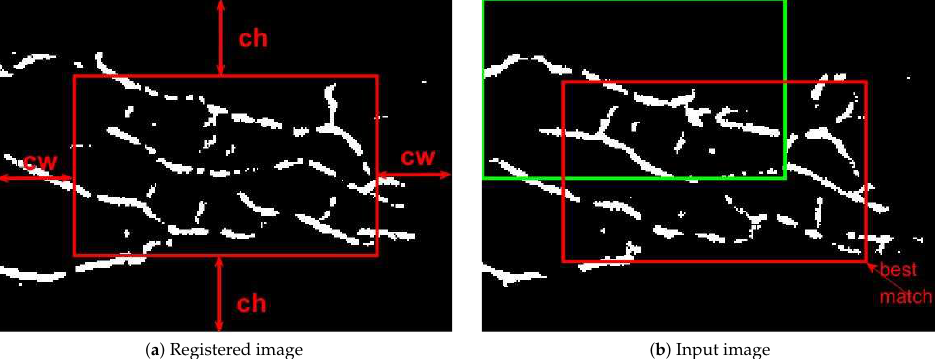
Figure 5. Template matching between the registered and input images. ( a ) Cut c w and c h from the registered image margin; ( b ) the best match between the registered and input images, the match ratio is